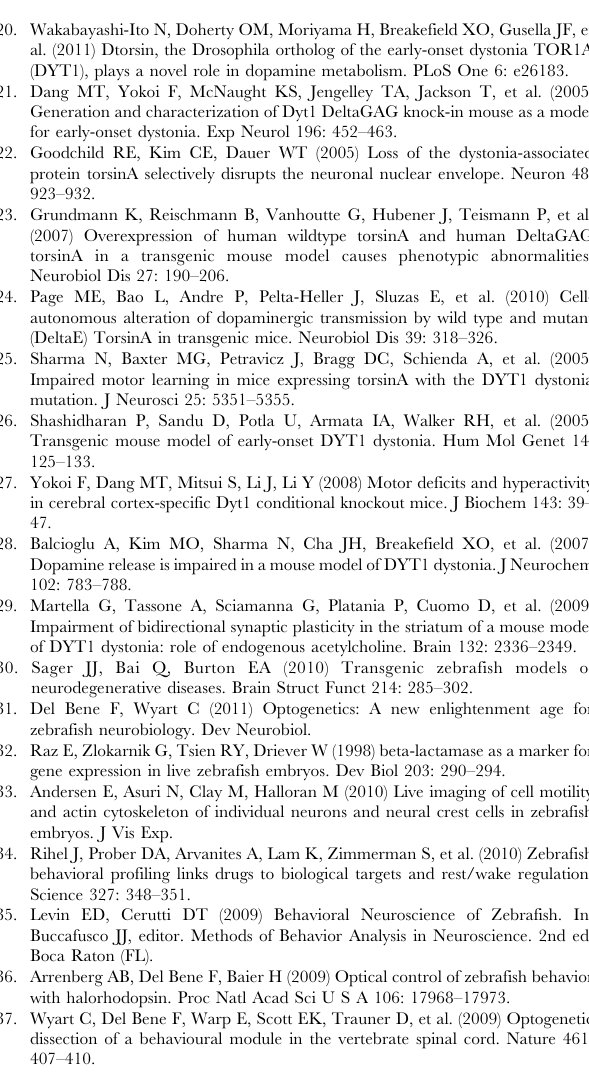
Table S1 Zebrafish homologs of TorsinA-interacting proteins. Human proteins known to interact with TorsinA are shown in